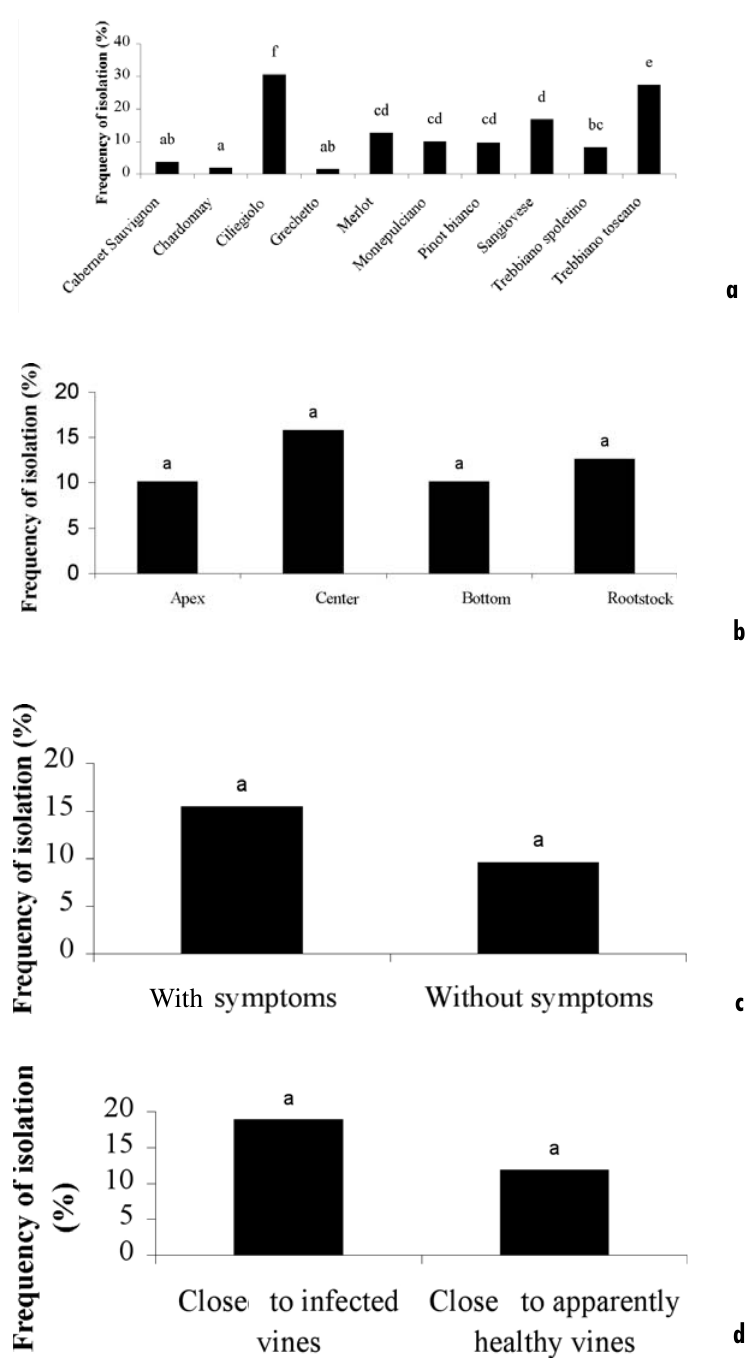
Fig. 5. Frequency of isolation of Phaeomoniella chlamydospora (a) on the ten cultivars grown in the vineyard of the Univer- sity of Perugia (Umbria, central Italy), LSD ( P =0.05) =15.45; (b) on the cross-section of the plants, LSD ( P = 0.05)= 11.35; (c) on vines that showed esca symptoms on leaves and berries and on vines that did not show these symptoms, LSD ( P = 0.05)=8.85; (d) on vines that did not show esca symptoms on leaves and berries and that were closed to infected or appar- ently healthy plants, LSD ( P =0.05)= 15.48.